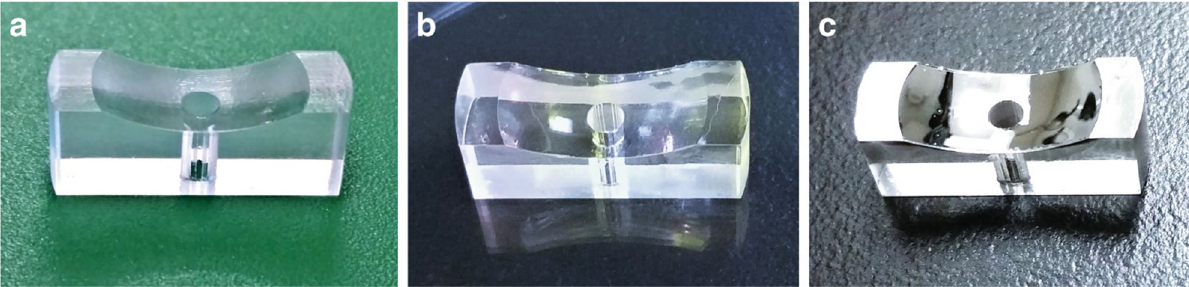
Figure 3: 3D - printed parabolic mirrors ( a ) as printed, ( b ) after smoothing, and ( c ) after Al deposition. From ref. ( 51 ) , originally published under a CC - BY